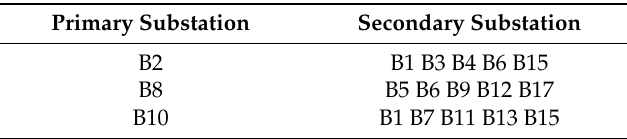
Table 1. Results of partitioning by planning number.